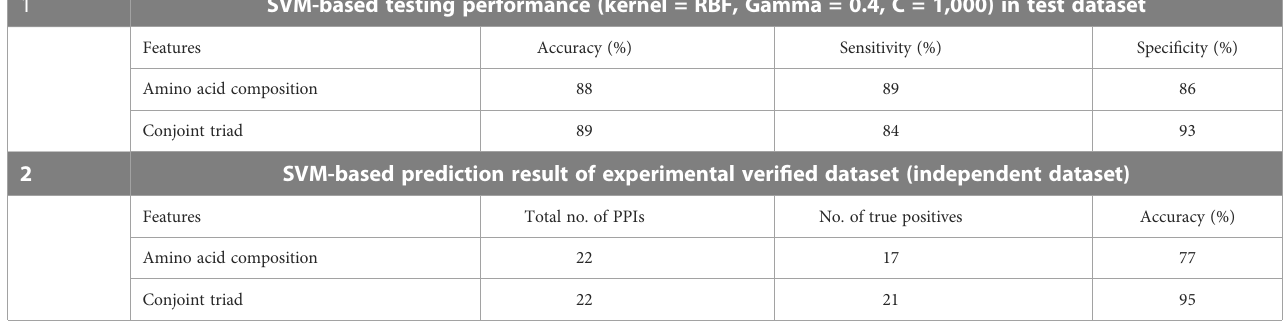
TABLE 5 SVM-based analysis result for amino acid composition and conjoint triad